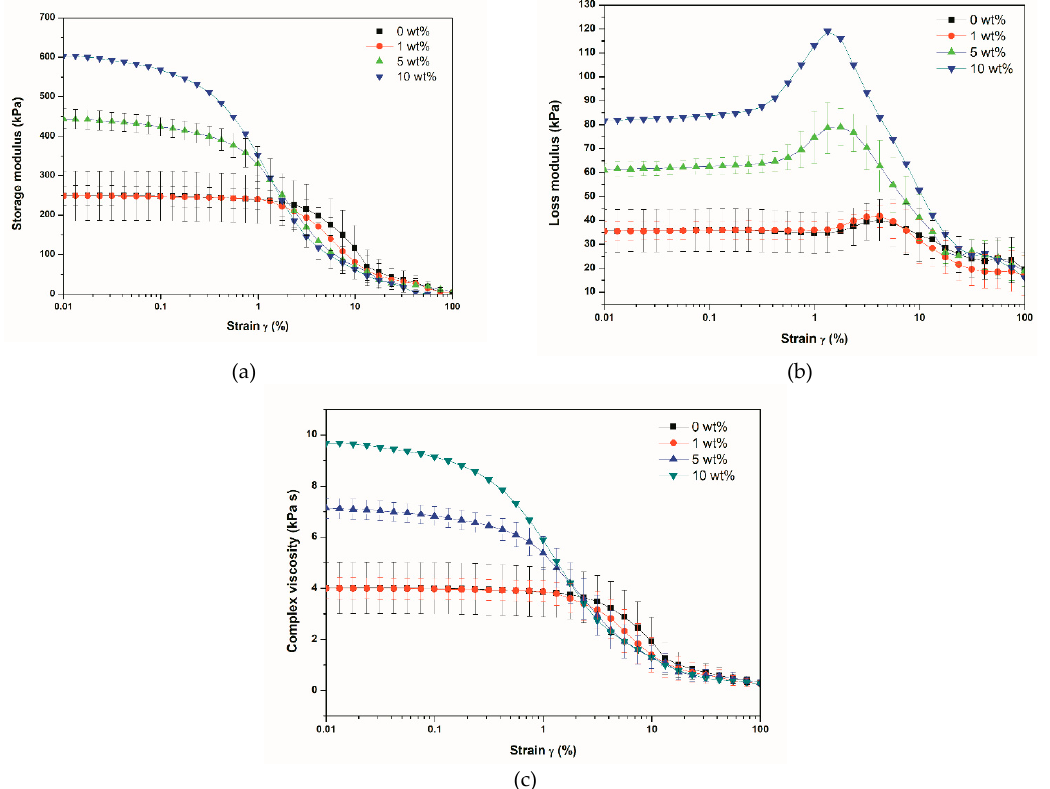
Figure 4. Variation of storage modulus (G’) ( a ), loss modulus (G’’) ( b ), and complex viscosity ( η *) ( c ) of SBR/BNNTs composites as a function of strain.